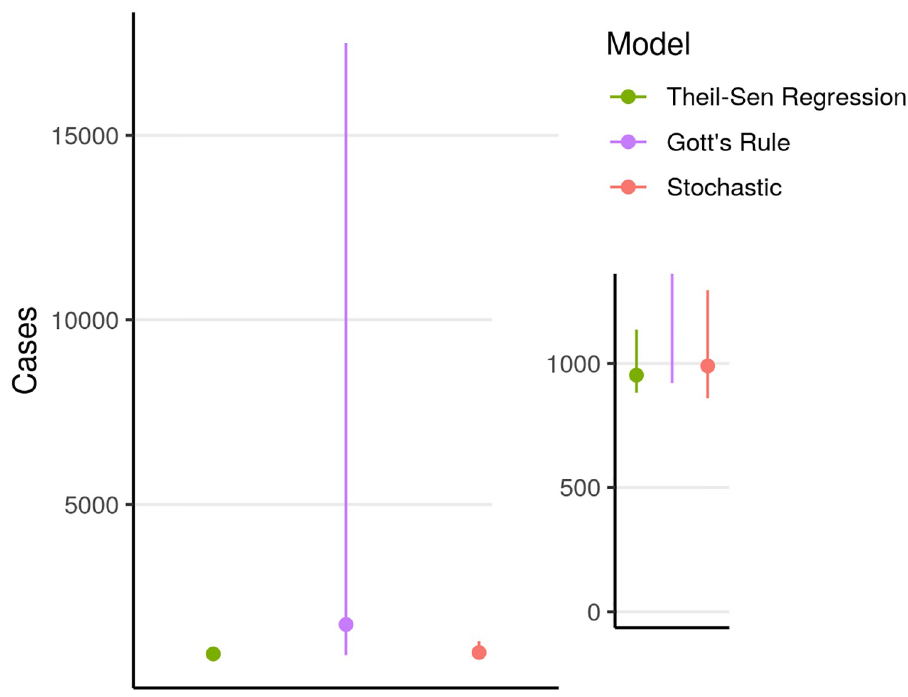
Fig 7. Medians and prediction intervals from projections of final case counts based on reported counts as of February 25, 2019. Solid dots indicate median size. Inset provides detail at smaller